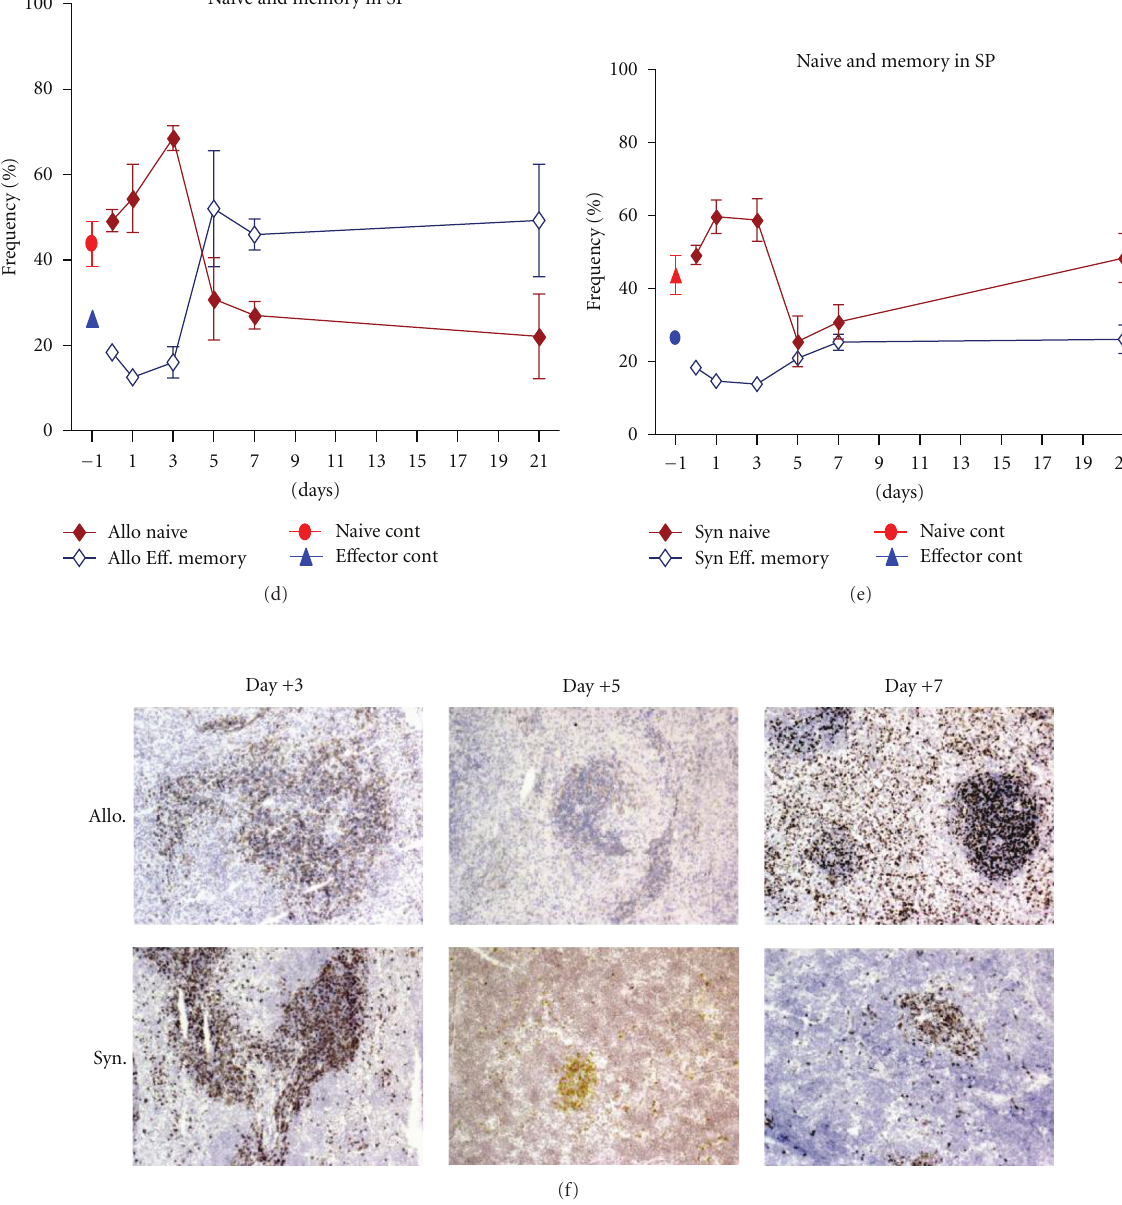
Figure 4: Chimerism and activation pattern of donor cytotoxic T cells in the spleen of GVHD mice. BALB/c mice were transplanted with 20 × 10 6 and 30 × 10 6 BM and SP cells from either allogeneic (C57BL/6) or syngeneic (BALB/c) donors. Spleens of transplanted recipients were evaluated using flowcytometry and histopathology methods. (a) Frequency of donor versus recipient T cells at di ff erent time points in the spleen of GVHD mice. ( (cid:2) ): donor (H-2Kb), ( ♦ ): host (H-2Kd) cells. (b) Large granular lymphocytes appeared 5 days after BMT in the spleen of GVHD mice however these cells decreased dramatically at day 7 after BMT. (c) Most of the granular large T cells (upper gate) at day +5 originated from donor. (d, e) Expansion pattern of na¨ıve (CD44 low CD62 high ) and e ff ector memory (CD44 high CD62 low ) T cells in the spleen of (d) allogeneic and (e) syngeneic transplanted mice. (f) Immunohistostaining of spleen in allogeneic (upper row) and syngeneic (lower row) setting indicate extensive spreading of CD8+ T cells (brown spots) in the spleen of allogeneic transplanted mice 5 days after BMT. ( (cid:2) ): na¨ıve (CD44 low CD62 high ), ( ♦ ): e ff ector memory (CD44 high CD62 low ) in allogeneic and syngeneic setting, ( (cid:2) ): na¨ıve (CD44 low CD62 high ), ( (cid:4) ): e ff ector memory (CD44 high CD62 low ) in normal BALB/c mice. Di ff erences were analyzed statistically employing U -test, compared between groups ( ∗ P < .